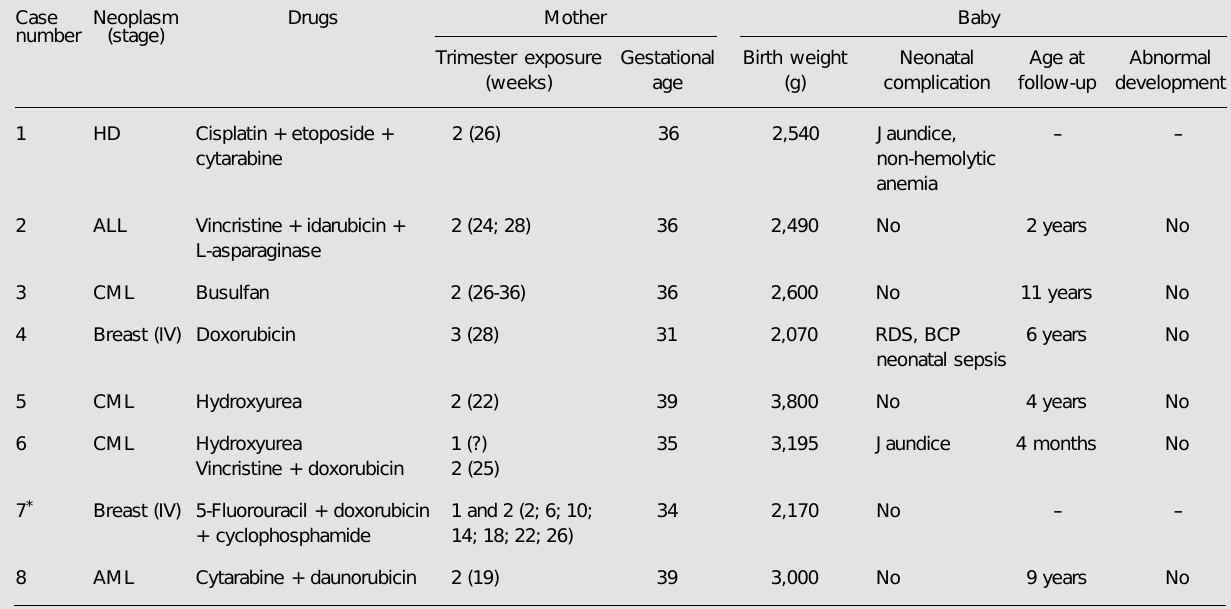
Table 3. Exposed group: outcome (livebirths) and chemotherapy employed. Case